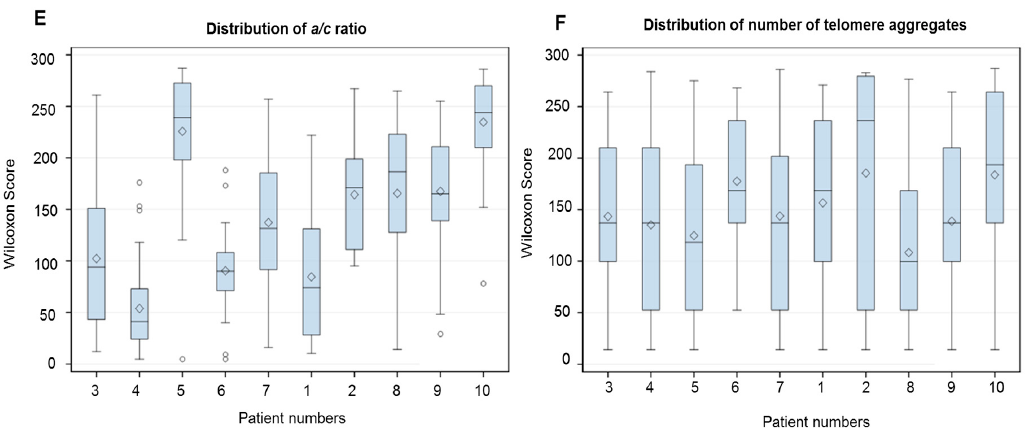
Figure 3. Representative bar plots to illustrate the intra and inter-sample variability of all telomere parameters. ( A ) Nuclear volume. ( B ) Total telomere signal intensity. ( C ) Average intensity (proportional of telomere length). ( D ) Total number of telomere signals. ( E ) a/c ratio (see material and methods). ( F ) Total number of telomere aggregates (see material and methods). The x-axis assigns one box for the CTC population analyzed per patient. The y-axis refers to output from Kruskal–Wallis test represented as Wilcoxon mean scores (determined using SAS software). Whiskers show minimum and maximum values, boxes represent 25–75% data ranges, horizontal lines within boxes are medians, and diamond symbols are means.